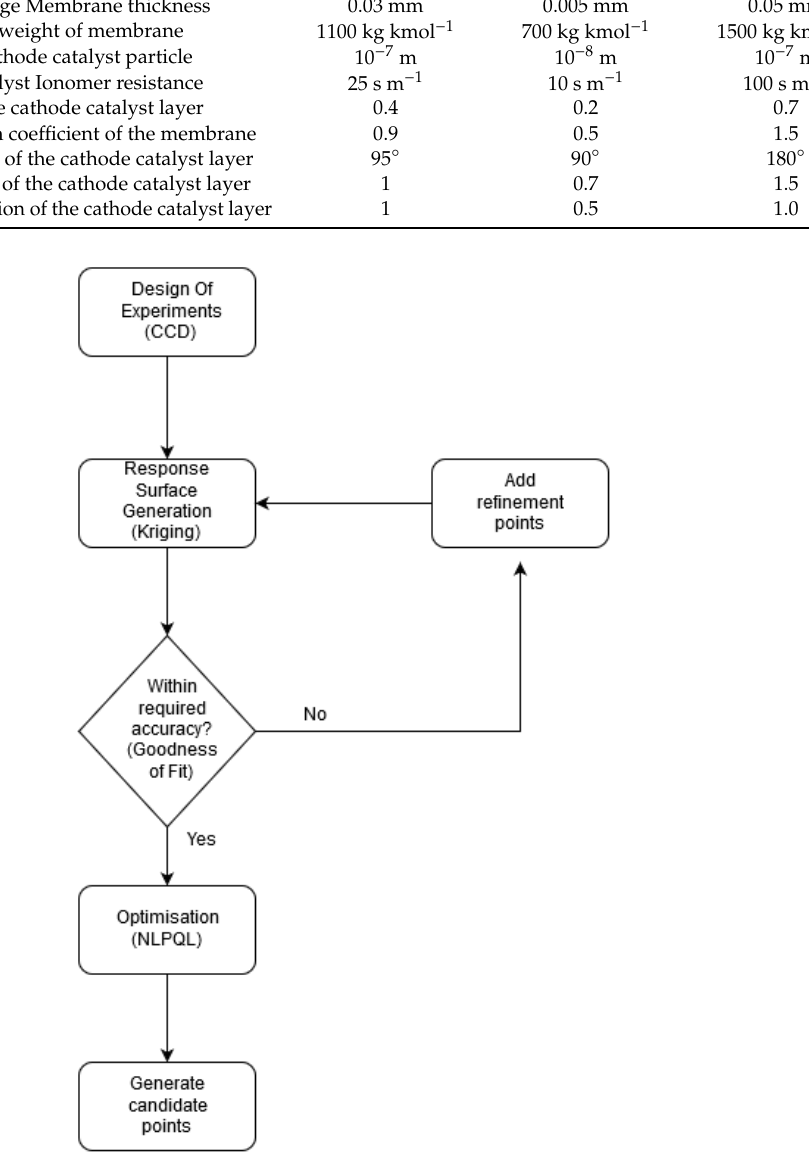
Figure 5. Flow diagram of response surface methodology.